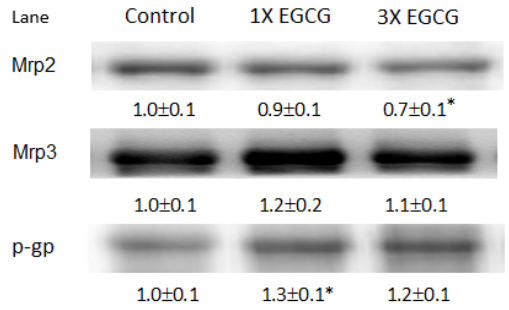
Figure 1. E ff ects of EGCG on membrane transporters in the livers of rats. Densitometry quantitation of membrane transporter protein (Mrp2 / 3 and p -glycoprotein, p-gp) levels from rats fed the EGCG diet for four weeks. Each lane represents the pooled liver membrane protein from five to six individual